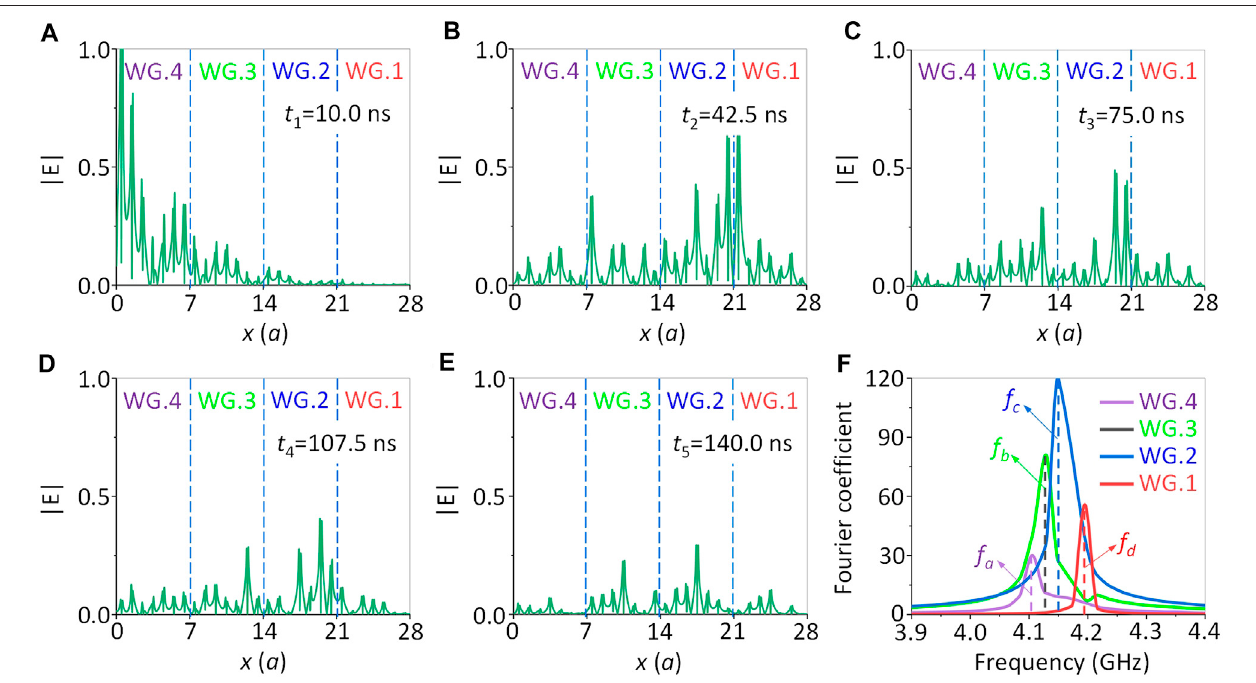
FIGURE9| Slowlightrainbowtrappingintimedomain.Electric fi eldamplitudesofthewavepacketalongthelowerboundaryatdifferenttimes: (A) t 1 (cid:1) 10.0 ns, (B) t 2 (cid:1) 42.5 ns, (C) t 3 (cid:1) 75.0 ns, (D) t 3 (cid:1) 107.5 ns, (E) t 3 (cid:1) 140.0 ns,and (F) Fouriertransformationspectrumat x 1 (cid:1) 4 a (WG.4), x 2 (cid:1) 11 a (WG.3), x 3 (cid:1) 18 a (WG.2),and x 4 (cid:1) 25 a (WG. 1) along the lower boundary of the waveguide channel.